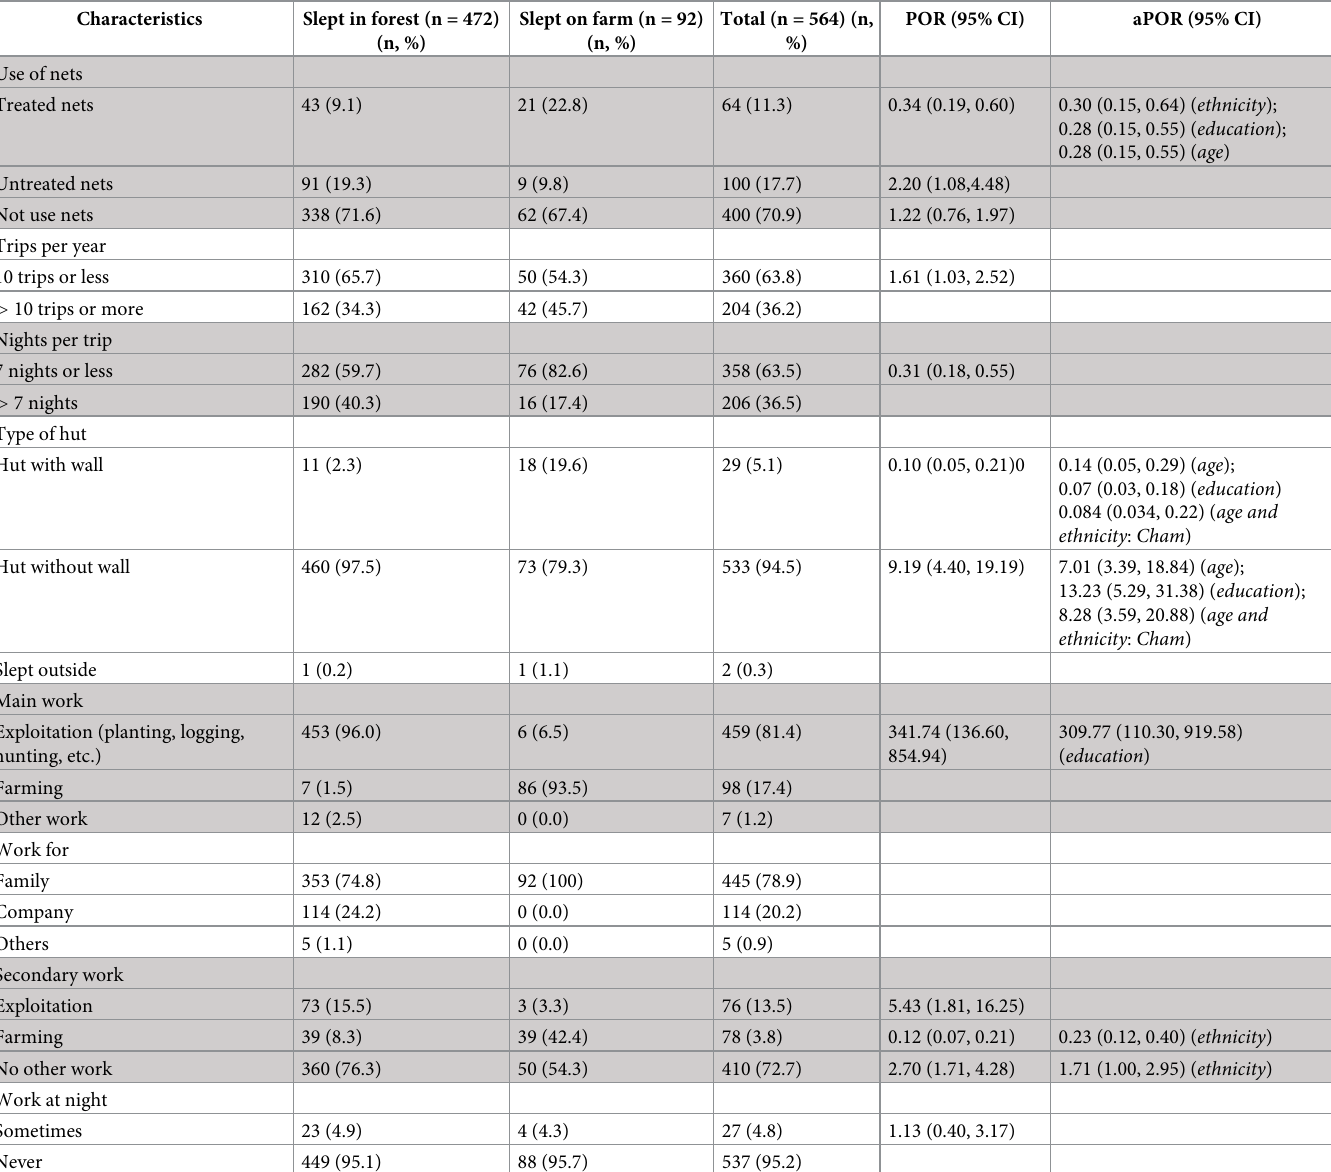
Table 3. Characteristics of primary respondents’ activities by sleeping sites in Dong Xuan District, Phu Yen Province, 2016.